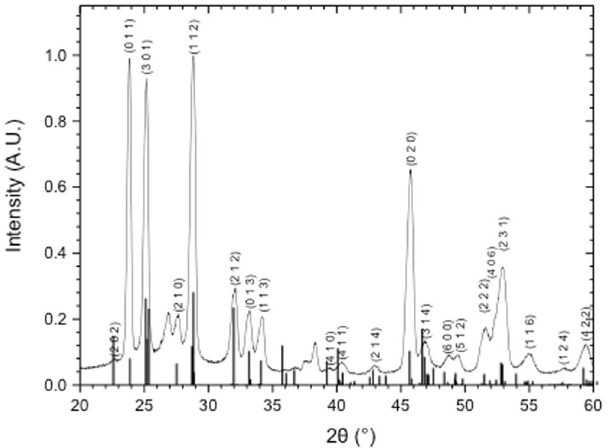
Figure 3. Grazing incidence x-ray diffraction scan of a bismuth sulphide film electrodeposited through a phytantriol template with superimposed pdf card 9007375 for Bismuthinite from the crystallographic open database.